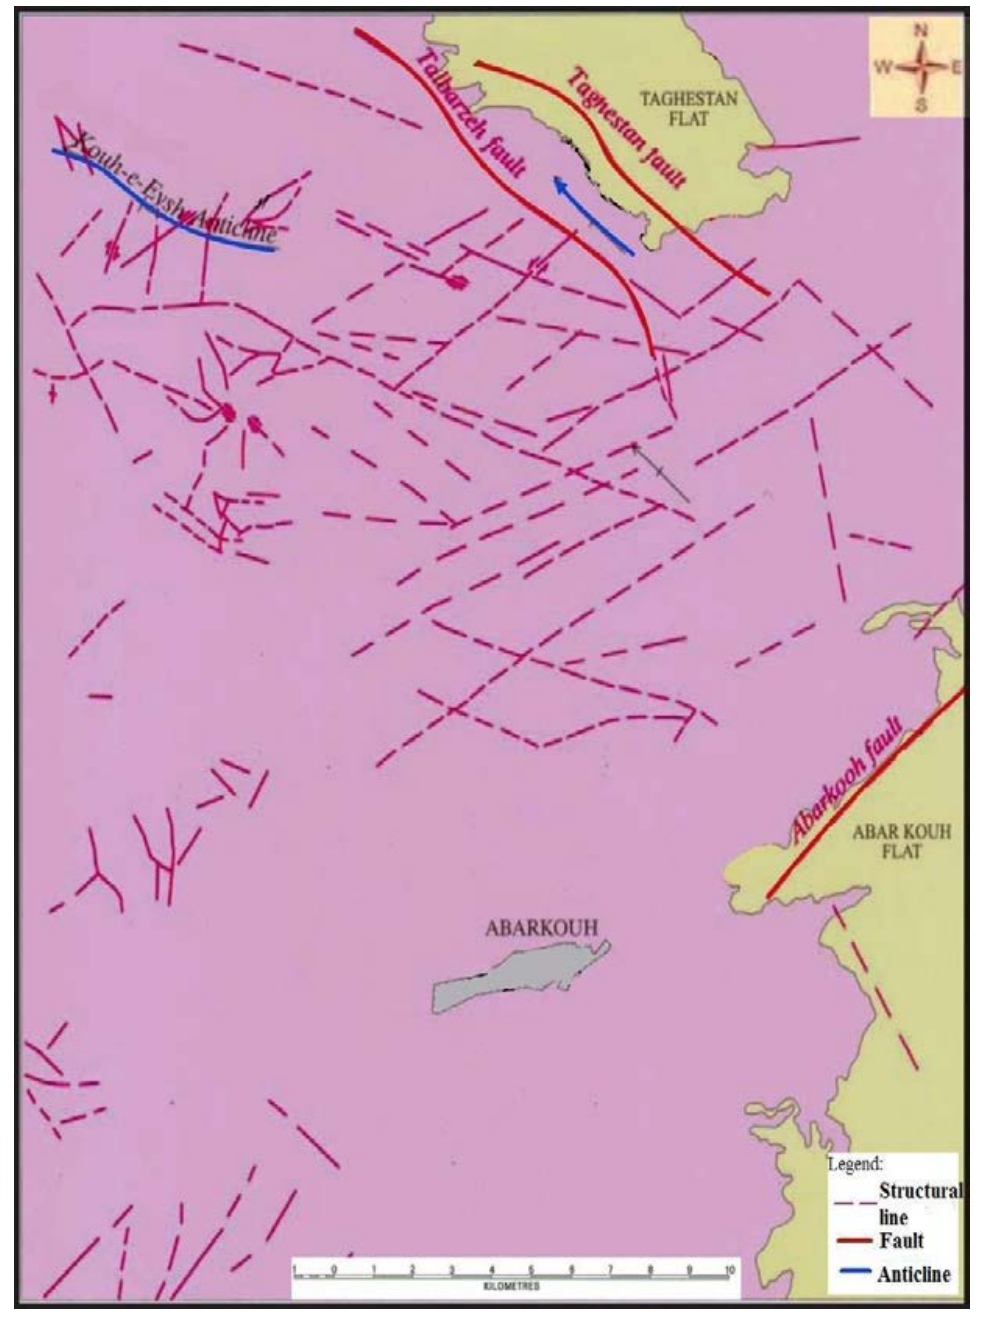
Figure 8. Structural map of the area.